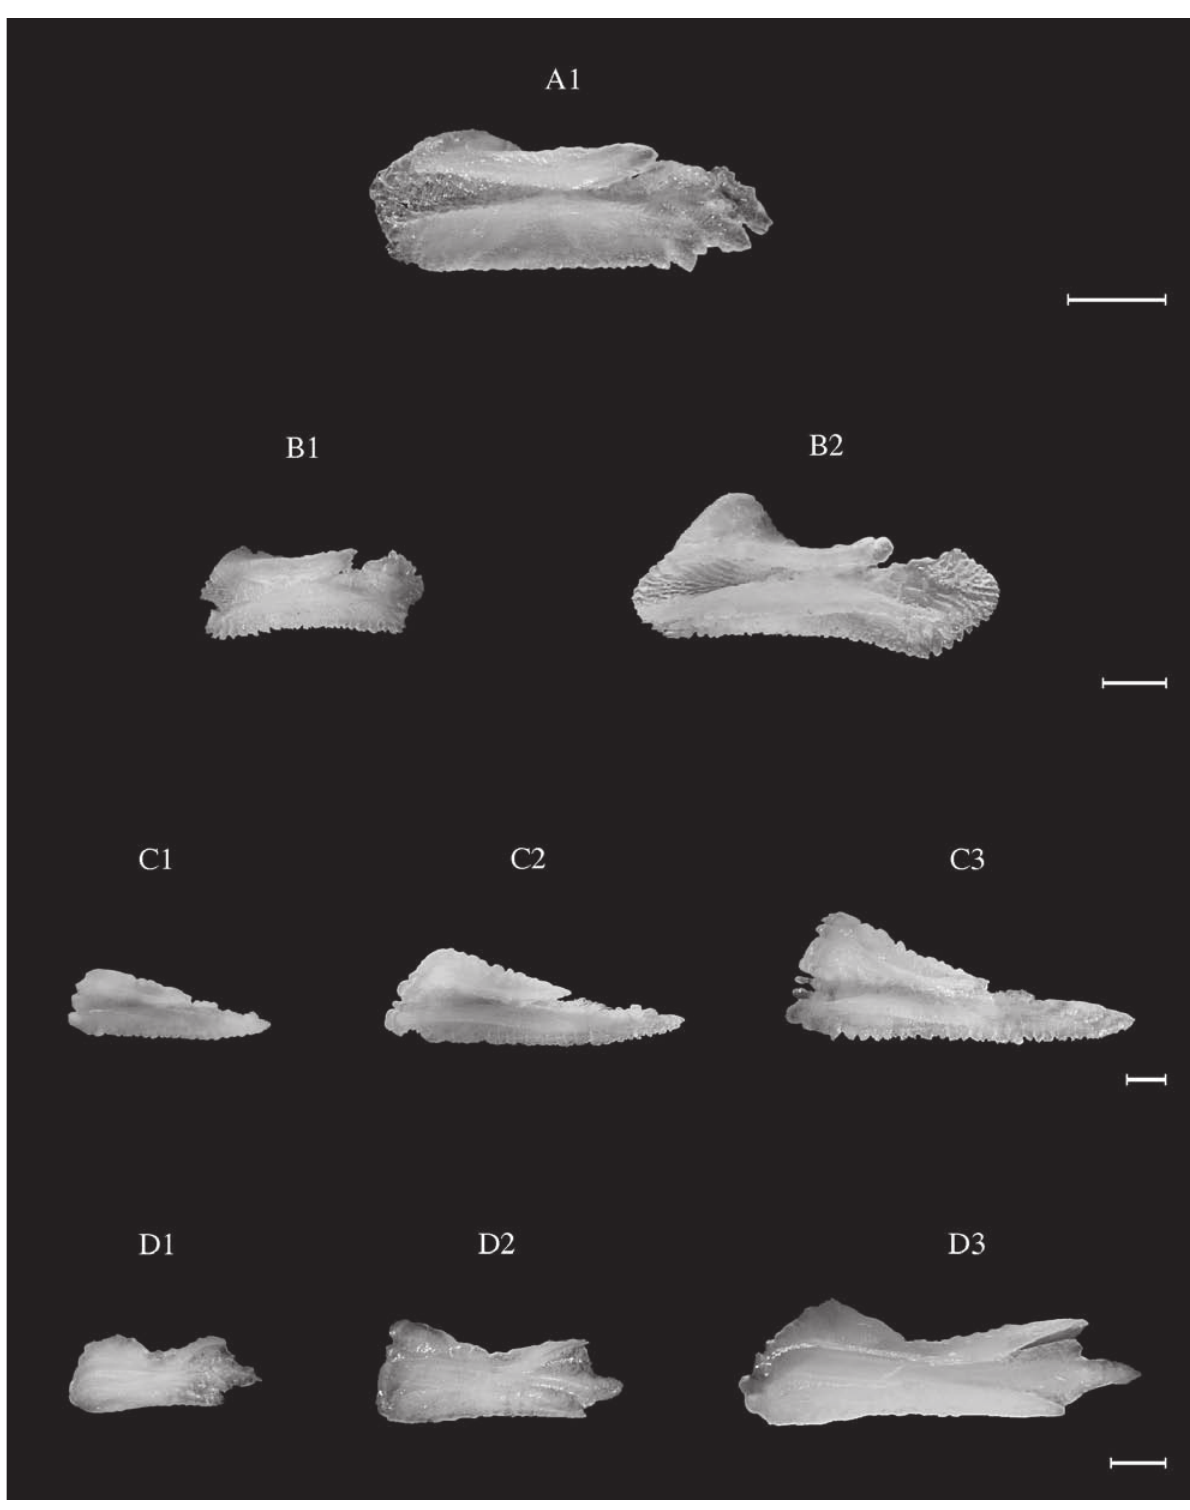
Fig. 84. – Euthynnus alletteratus (WM). FL: A1, 44.0 cm. Katsuwonus pelamis (CEA) . FL: B1, 41.2 cm. Sarda sarda (WM). FL: C1, 36.0 cm; C2, 59.0 cm; C3, 65.0 cm. Scomber colias . FL: D1, 18.6 cm (NEA); D2, 30.9 cm (CEA); D3, 40.5 cm (WM). Scale bar = 1